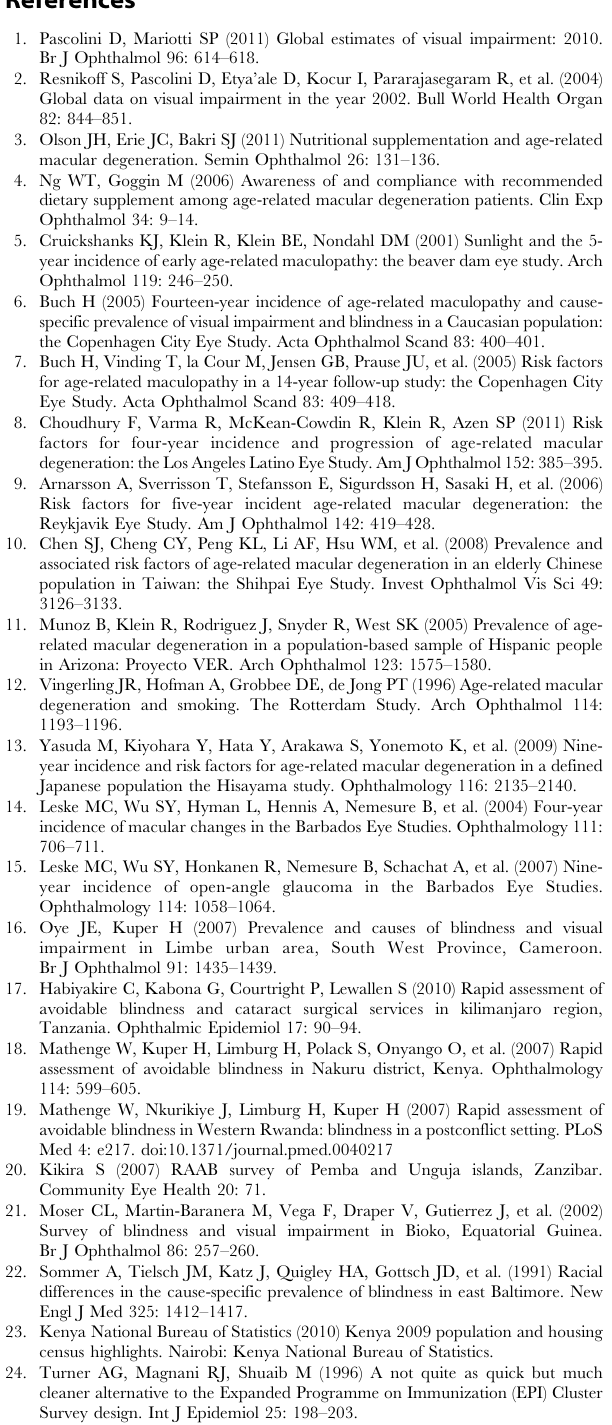
Table S1 Comparison of those with diagnosis based on retinal images with those who had only SLB diagnosis. Table S2 Demographic characteristics including age as a continuous